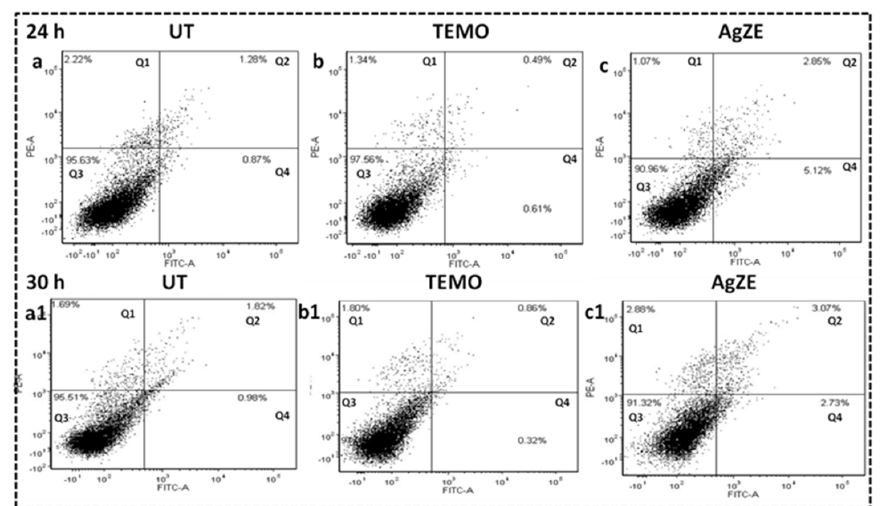
Figure 5. Apoptosis analysis with flow cytometry using Annexin V-FITC in U-87 cell line at 24 h (upper row) and 30 h (lower row) time points, where groups are: ( a , a1 ) untreated: UT ( b , b1 ) temozolomide: TEMO, positive control, and ( c , c1 ) AgZE (IC50: 4.1 µL). AgZE treated U-87 cells exhibits increase in cell population in early apoptotic phase at 24 h which later moves to late apoptotic region at 30 h.